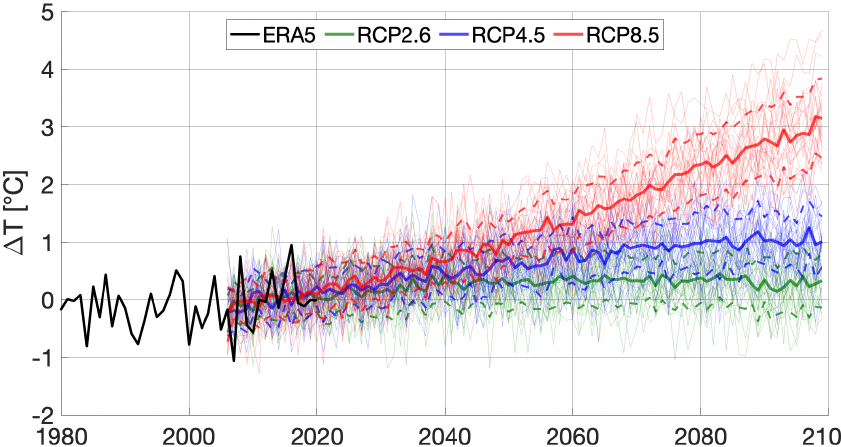
Figure 4. Temperature projections for the Mocho-Choshuenco ice cap through the 21st century for three different scenarios, RCP2.6, RCP4.5, and RCP8.5, along with historical ERA5 data which are used for the transient spin-up. The thin lines show projections of the 23 individual climate models, thick solid lines indicate their mean, and thick dashed lines indicate the 1 σ confidence interval. The period between 2006 and 2020 is used as the reference period for each individual